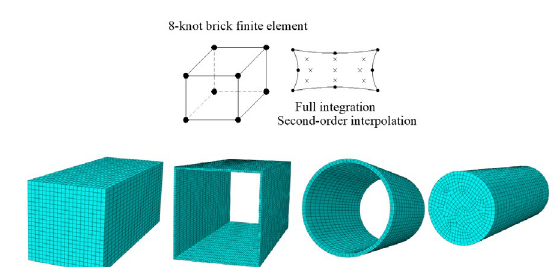
Figure 1. Refinement and type of element and mesh in the steel tube and concrete core.